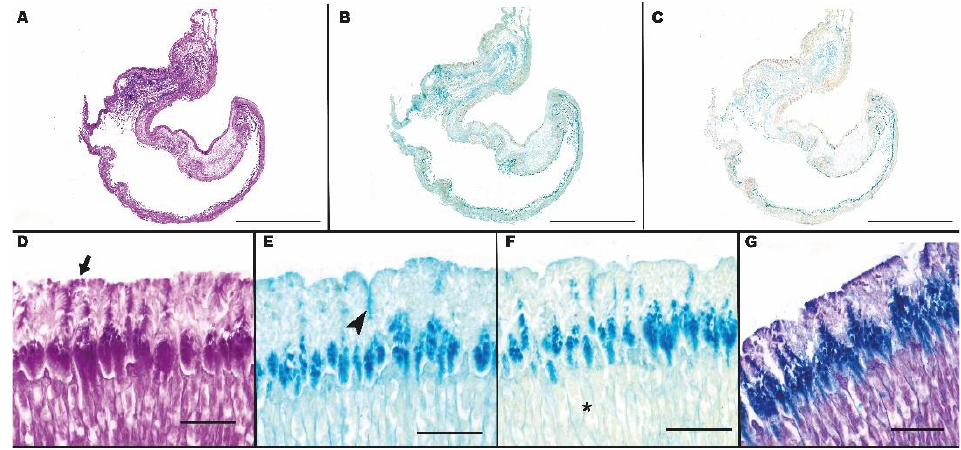
Figure 6. Histochemical investigation of the stomach of Nile tilapia. Figure shows periodic acid Schiff (PAS )( A,D ); Alcian blue at pH 2.5 ( B,E ); Alcian blue at pH 1.0 ( C,F ); and Alcian blue/PAS ( G ) binding sites on mosaics of the whole stomach. Epithelial cell coat (arrow); Gastric pits (asterisk); Gastric glands (arrow head). D, E and F represent magnifications (40x) of PAS, Alcian blue at pH 2.5, and Alcian blue at pH 1.0, respectively. Scale bars = A,B,C: 1 cm; D,E,F,G: